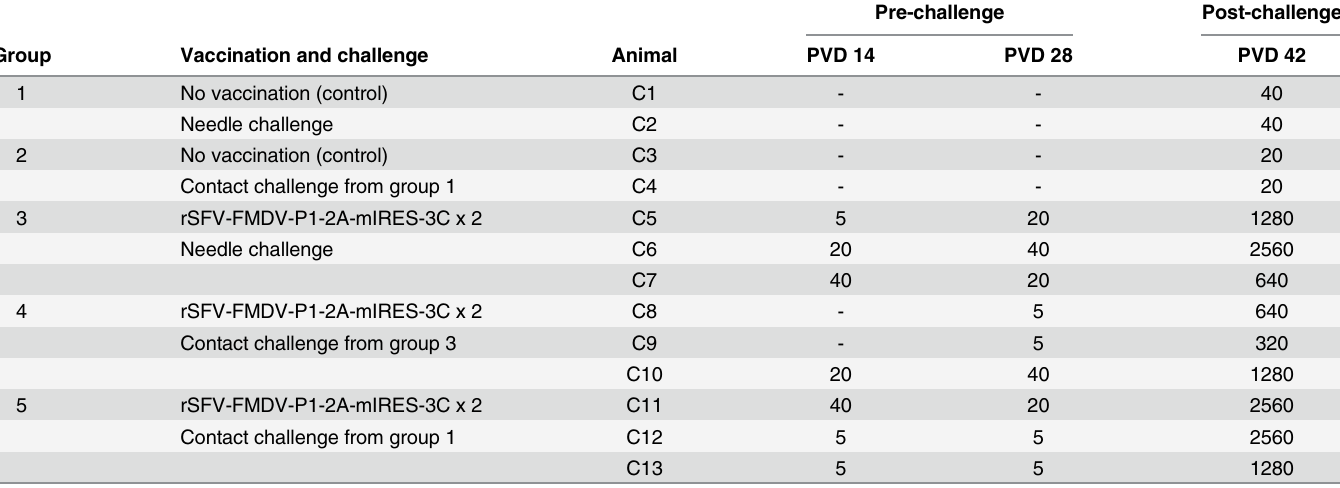
Table 2. Reciprocal titres of anti-FMDV antibodies (serotype O) in sera from unvaccinated and rSFV-FMDV vaccinated calves in experiment 2.